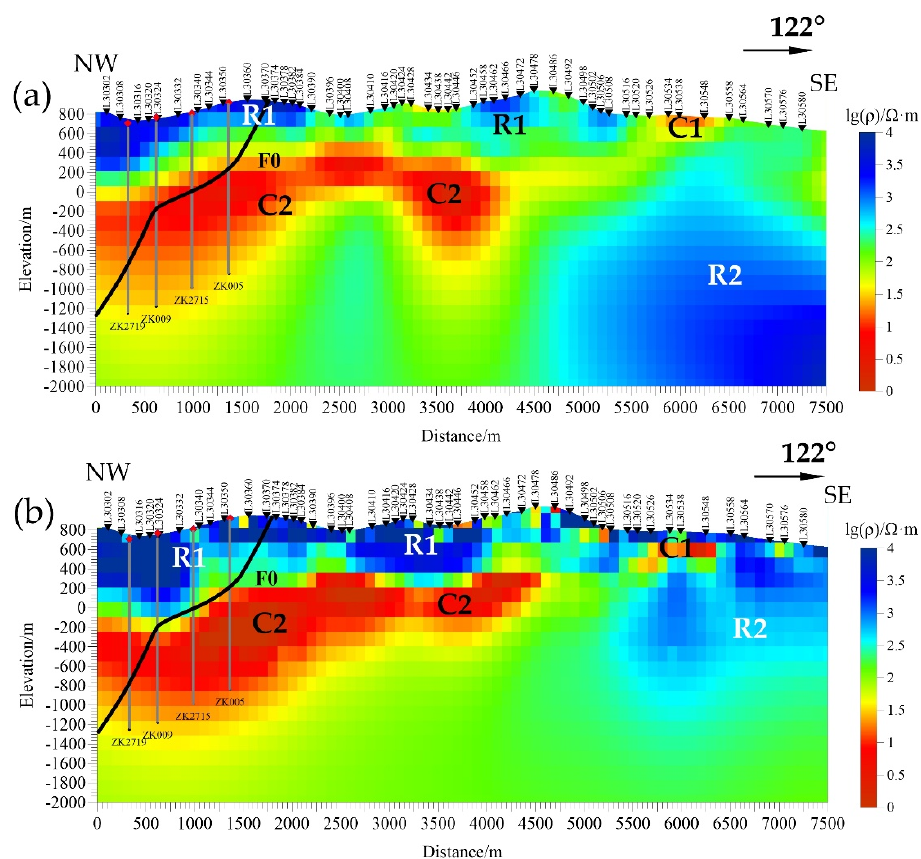
Figure 4. ( a ) The resistivity model of 2D inversion. ( b ) The resistivity model of 3D inversion. C1 and C2 denote conductors. R1 and R2 show resistors. The regional fault, F0, is indicated by a black